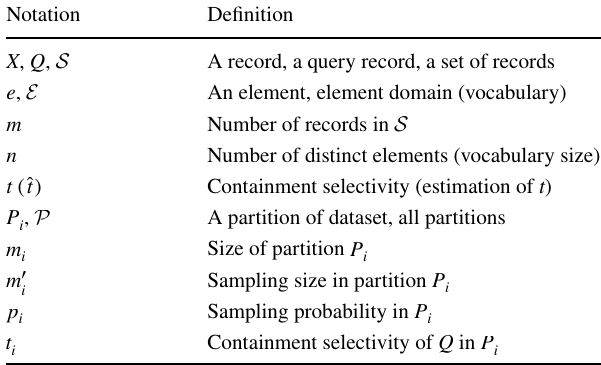
Table 2 Summary of